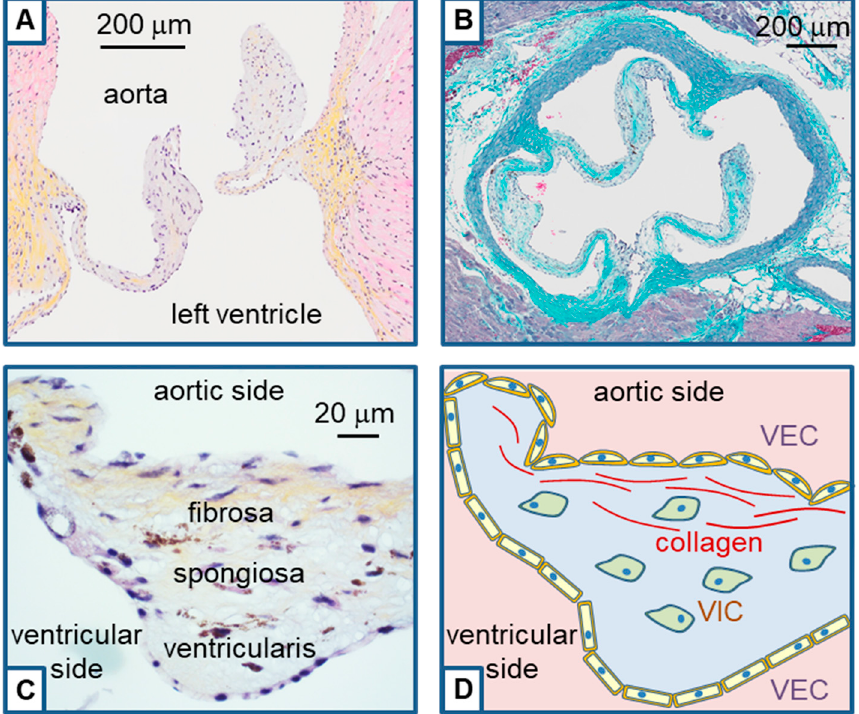
Figure 1. Structure of the aortic valve. ( A ): Histological slice performed in the longitudinal axis (3- µm-thickness) of the aortic valve of a mouse. Aorta is on the upper side and the left ventricle in the lower side. The slice was stained with hematoxylin, eosin and sa ff ron (HES) to reveal cell nuclei (blue), cytoplasm (pink), and collagen fi bers (yellow). ( B ): Histological slice performed in the transversal axis (3-µm-thickness) of the aortic valve of a mouse, allowing the observation of the three lea fl ets. The slice was stained with Masson trichrome revealing collagen fi bers in cyan. ( C ): Magni fi cation of a slice performed in the longitudinal axis (3-µm-thickness) of the aortic valve of a mouse at the level of a lea fl et (HES staining). Collagen fi bers (yellow staining) appear in the fi brosa . Note the di ff erence in endothelium morphology between the aortic and ventricular sides. ( D ): Outline of the slice presented in C to highlight valvular endothelial cells (VEC) lining the lea fl et and valvular interstitial cells (VIC) within the lea fl et.